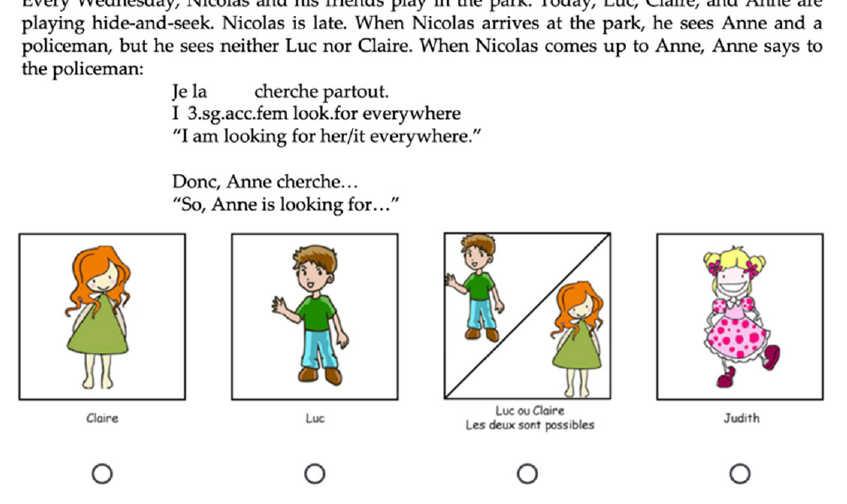
Figure 1. Sample item, picture selection task.